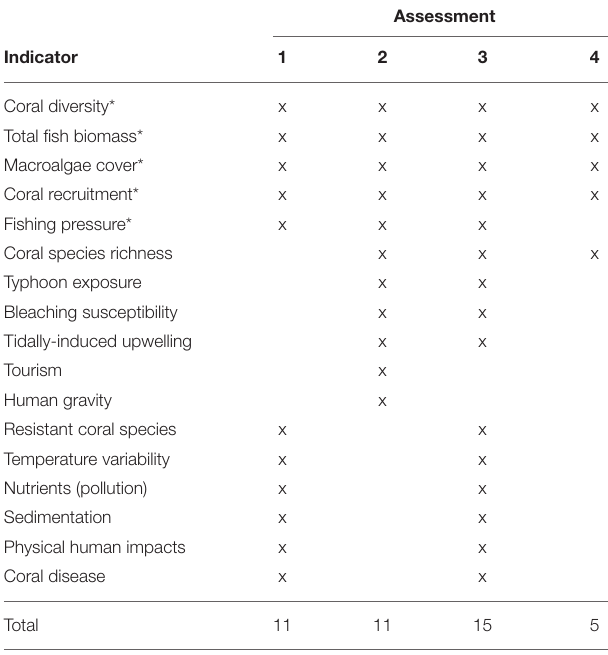
TABLE 1 | Summary of indicators (marked with an “x”) used in four assessments: (1) workshop-scored indicators, (2) localized indicators and biodiversity survey metrics, (3) combined indicators from Assessments 1 and 2, (4) biodiversity survey metrics